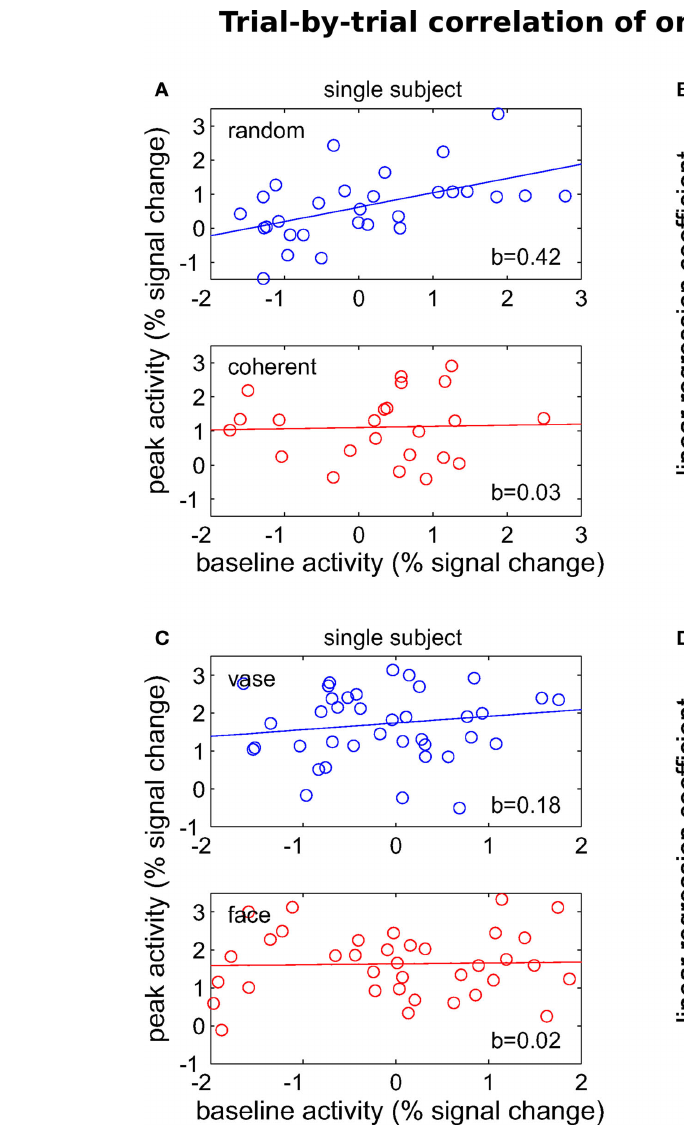
FIguRe 4 | Percept-dependent and non-linear interaction of evoked responses with pre-stimulus baseline activity. Percept-dependent linear regression was performed between trial-by-trial pre-stimulus activity at − 1.5 s and peak activity at 6 s relative to stimulus onset. For two independent experiments, the regression is illustrated for one representative single subject and the regression coefficient is given for the group. (A,B) The motion decision experiment (for stimuli cf. Figure 3C ): coefficients were significantly larger than 0 when motion was perceived as coherent ( t